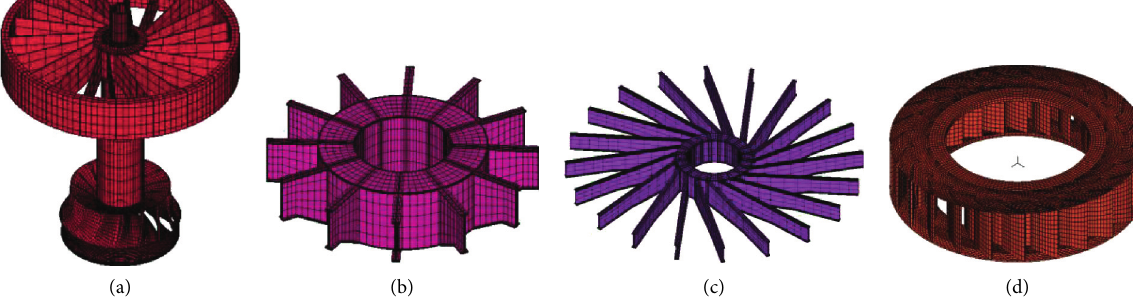
Figure 5: 3D structured grids for the mechanical domain. (a) Runner, axis, and rotor. (b) Lower brackets. (c) Upper brackets. (d) Stay and guide